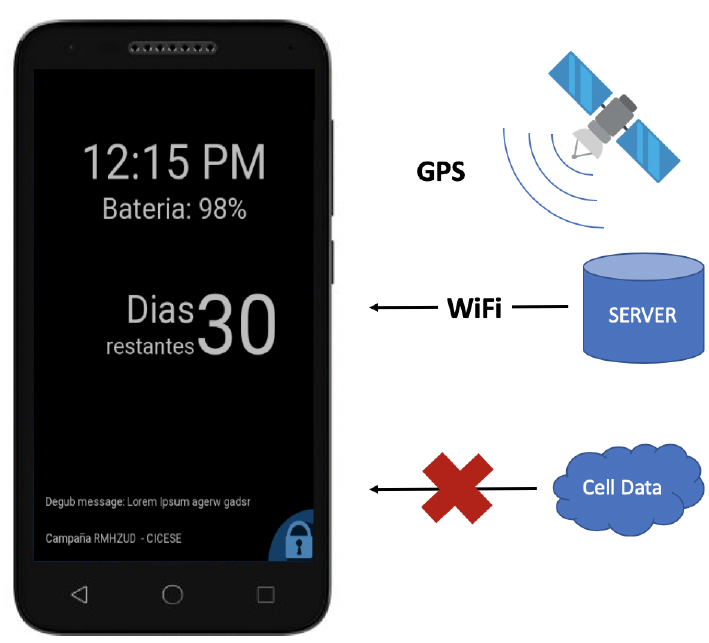
Figure 3. During the crowdsensing campaign, phones do not have access to a data network and run in non-interactive